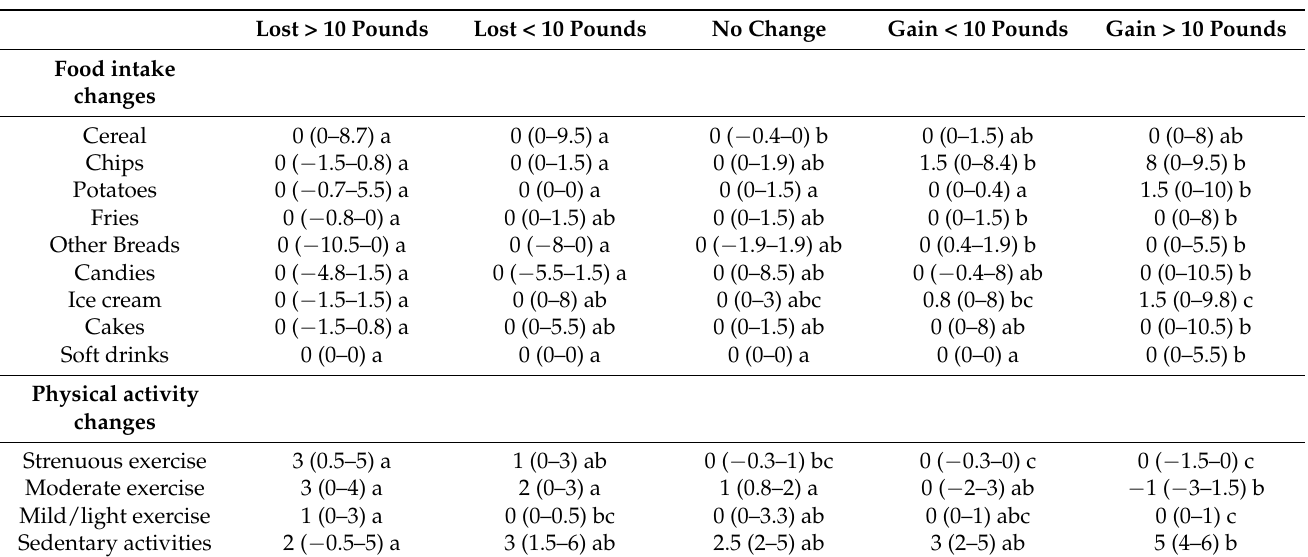
Table 3. Changes in food consumption and exercise intensity according to weight change (pounds). One-way ANOVA rank tests were used. Significant changes are represented by non-overlapping letters across the rows.